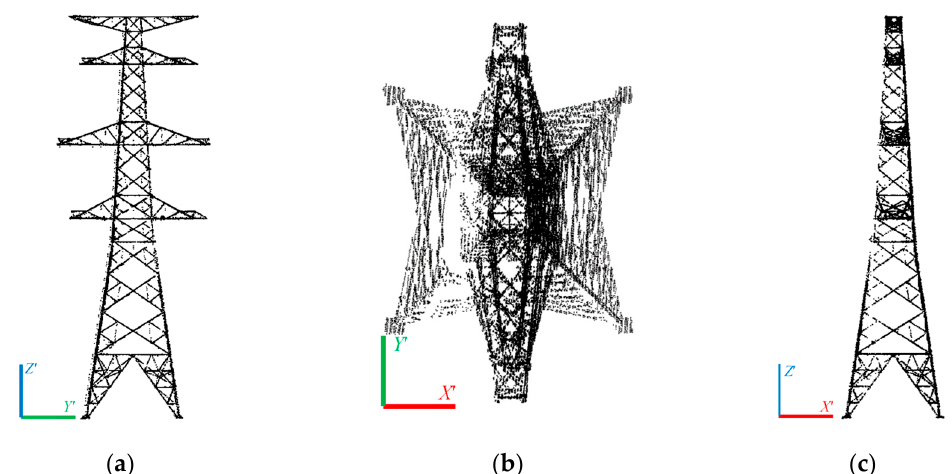
Figure 3. The projection views of pylon after redirection: ( a ) A pylon after redirection is projected to Y ′ Z ′ plane; ( b ) a pylon after redirection is projected to X ′ Y ′ plane; ( c ) a pylon after redirection is projected to X ′ Z ′ plane.